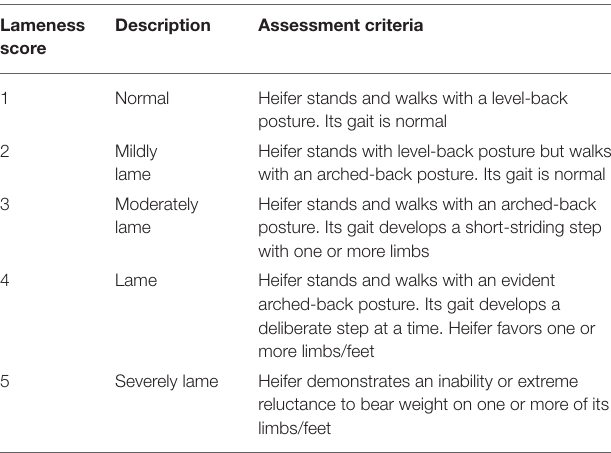
TABLE 1 | Locomotion scoring system of dairy cows based on Sprecher et al. (25). Lameness